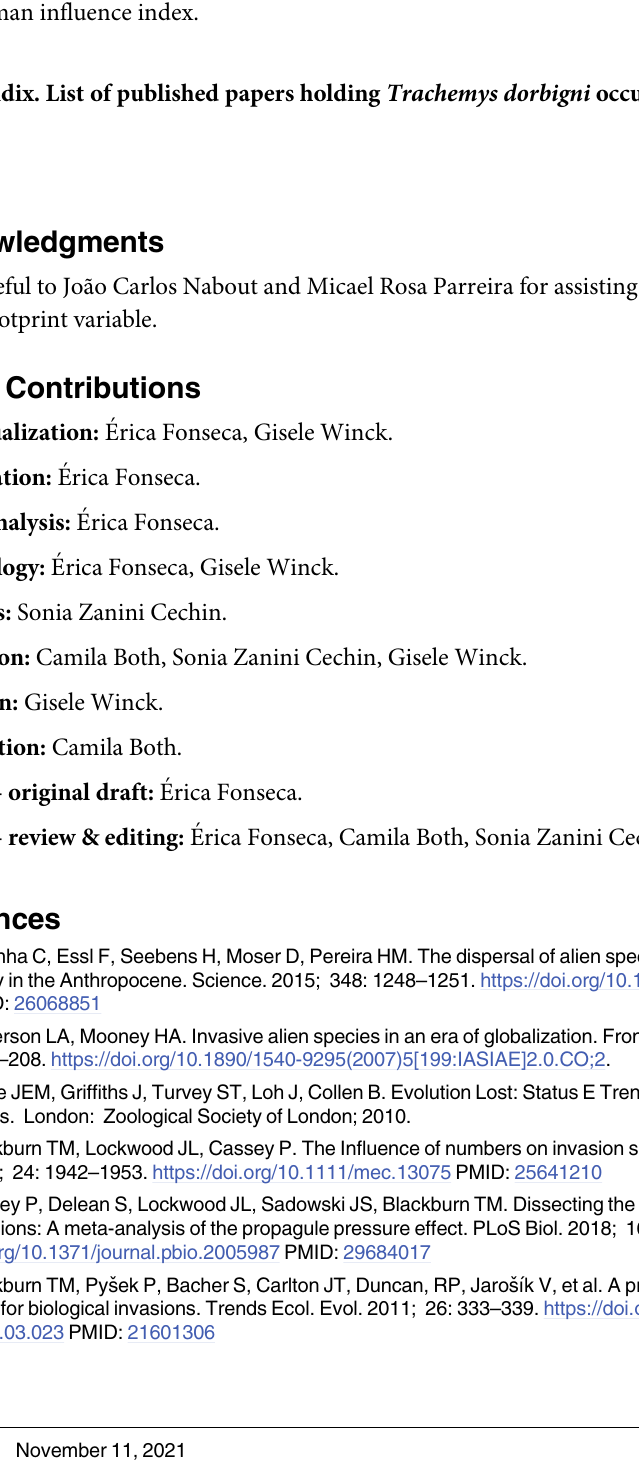
S1 Table. Geographic coordinates, states and country of occurrence records of Trachemys dorbigni . S2 Table. Variables importance (mean values ± SD) from the climate-only (CD) and com- bined (climate + human activity; CHD) models for Trachemys dorbigni . Variables: bio3 = isothermality; bio7 = temperature annual range; bio8 = mean temperature of wettest quarter; bio10 = mean temperature of warmest quarter; bio15 = precipitation seasonality; HII = human influence